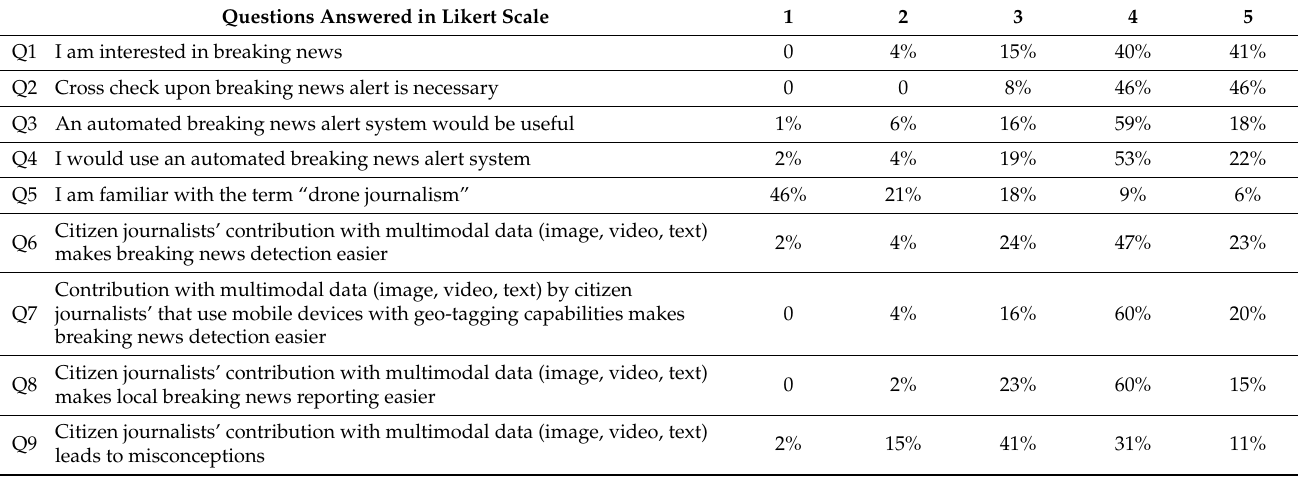
Table 2. The analysis questionnaire was answered by 100 people. (1: strongly disagree, 2: disagree, 3: neutral, 4: agree, 5: strongly